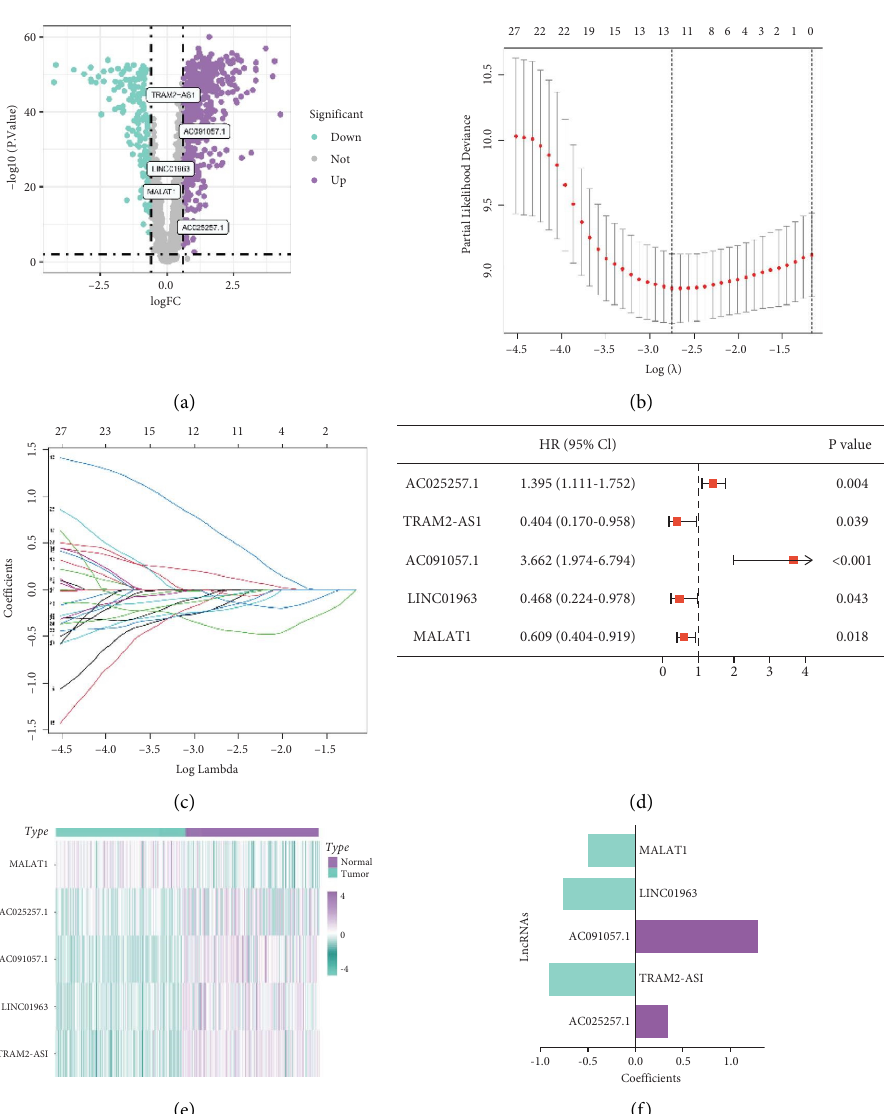
Figure 1: Identifcation of prognostic cuproptosis-related lncRNAs by LASSO regression and Cox regression analysis. (a) Volcano plot of 832 diferentially expressed lncRNAs. (b, c) Selection of the optimal parameter (lambda) in the LASSO model for pancreatic cancer. (d) Forest plot of multivariate Cox regression of fve lncRNAs. (e) Heatmap for the expression of fve lncRNAs in pancreatic cancer tissues and normal tissues. (f) Te coefcients of each